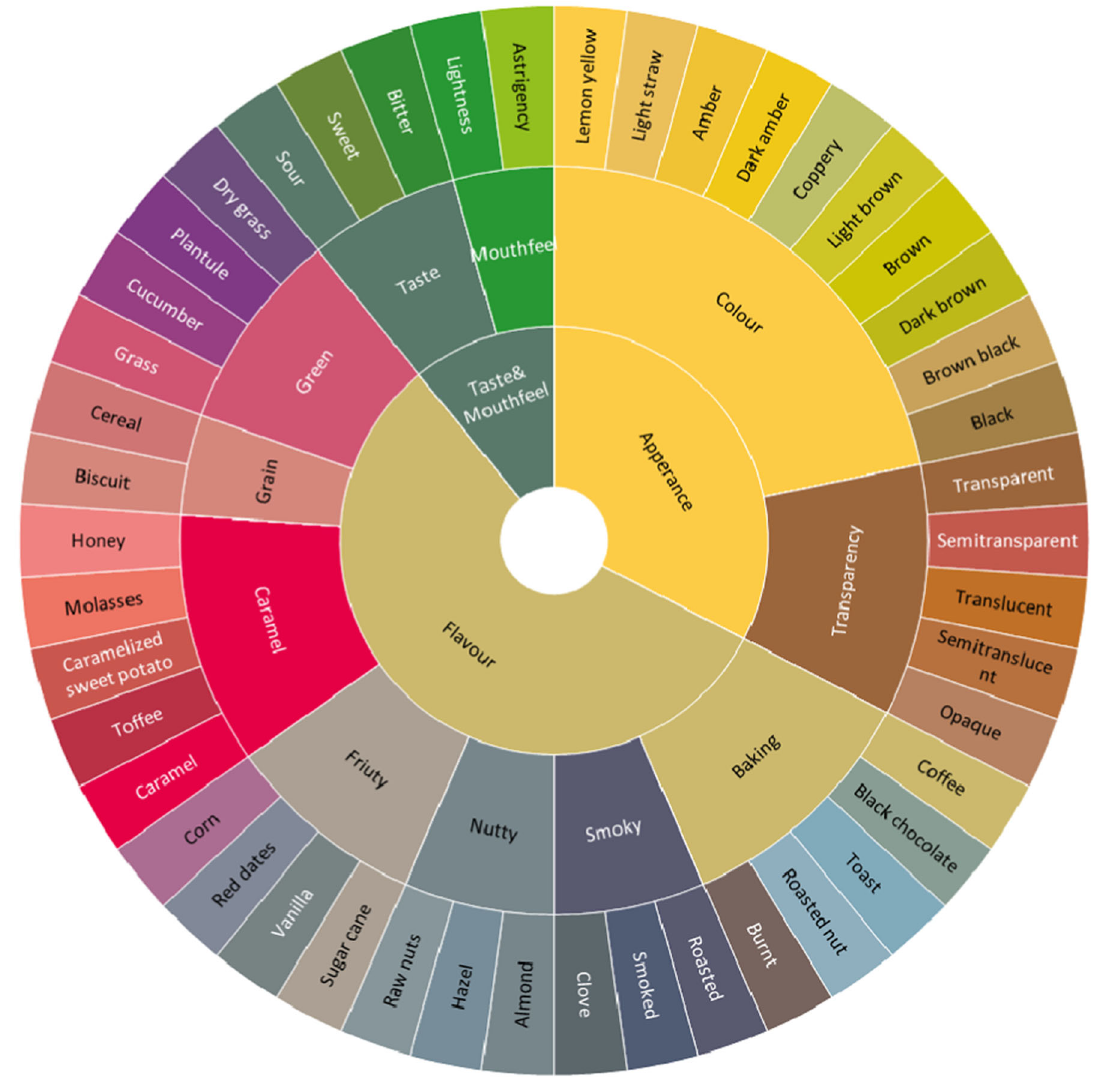
Fig. 1 Sensory wheel of brewing malts. 46 speci fi c attributes of brewing malt were illustrated in a three-circle sensory wheel, including 15 appearance attributes, 26 fl avour attributes and 5 taste and mouthfeel